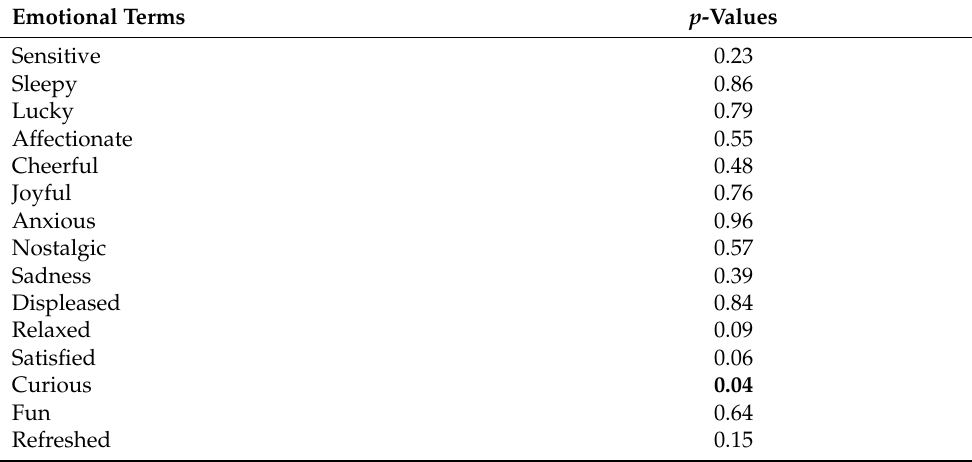
Table 4. p -Values of the emotional terms considering age–gender